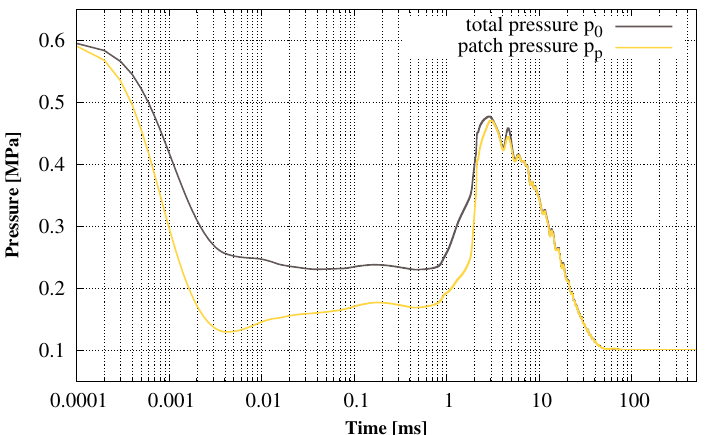
Figure 3. Time distribution of inlet static pressure for both investigated cases on the background of the total pressure. Reproduced from [32].